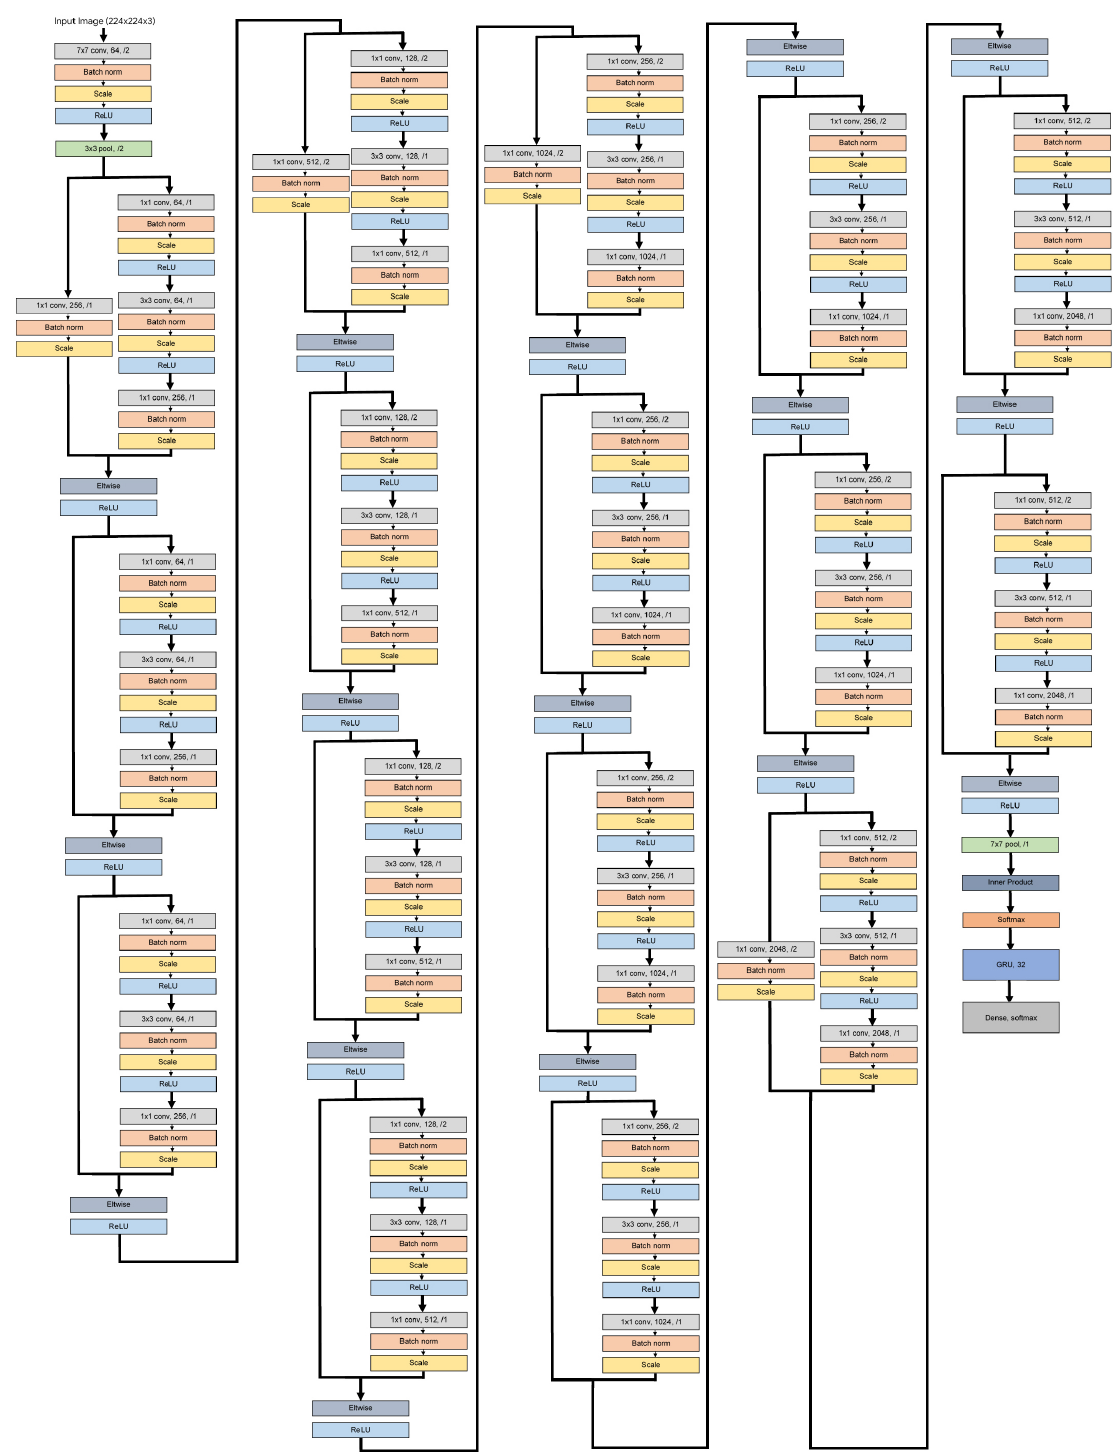
Figure 5. Layer architecture of C2R combining a ResNet50, a layer with an GRU and a dense layer with softmax